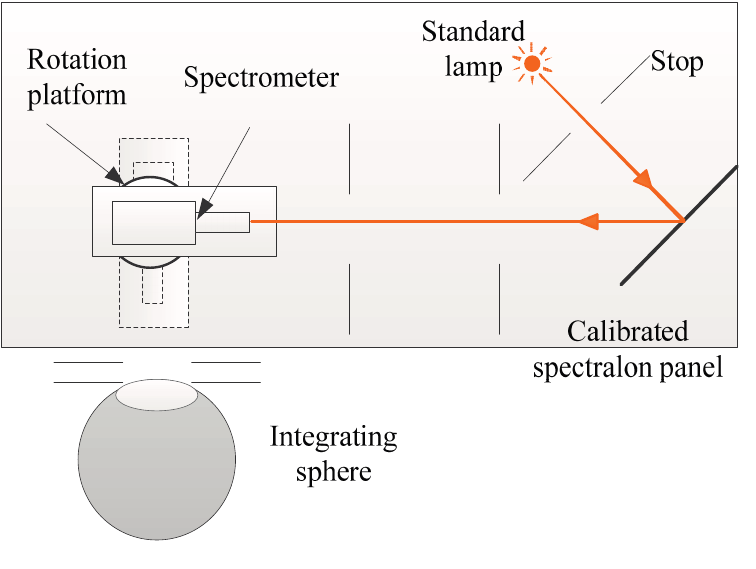
Figure 11. The configuration of the standard-lamp-based radiometric calibration in the